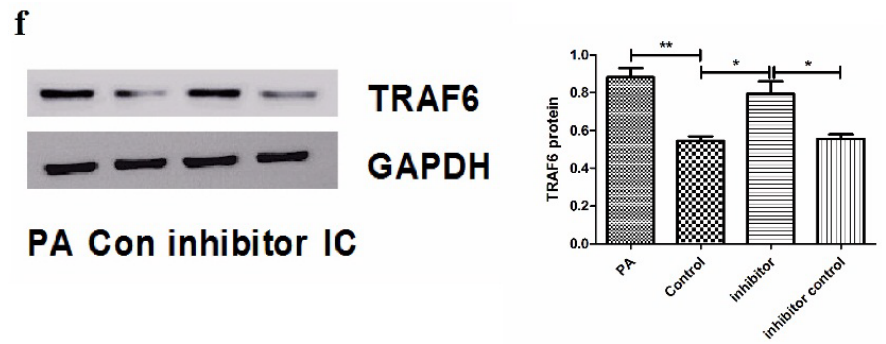
Figure 2. PA induces miR-194 downregulation and miR-194 directly targets TRAF6 in THP-1cells. ( a ) The sequence alignment of miR-194 and its putative target sites of the human TRAF6 mRNA 3′untranslated region were shown; ( b ) THP-1 cells were exposed to 250 μM PA for 8 h and detected the expression of miR-194 and TRAF6 through quantitative real-time PCR; ( c ) Constructed plasmids were transfected into THP-1cells for 24 h and then exposed to different concentration PA for 8 h; ( d ) THP-1 cells were transiently co-transfected with luciferase reporter vectors and miR-194 inhibitor or its control. Constructed luciferase reporter plasmid and miR-194 mimics were co-transfected into THP-1cells for 24 h and then exposed to 250 μM PA for 8 h. All of these whole-cell extracts were prepared for luciferase assay; ( e , f ) THP-1 cells were transfected with miR-194 mimics or its control for 24 h and followed 250 μM PA stimulation for 8 h. miR-194 inhibitor and its control were transfected into THP-1 for 32 h. All the above whole-cell extracts were collected for Western blot analysis. Results are mean ± SD. * p < 0.05 and ** p < 0.01, *** p <